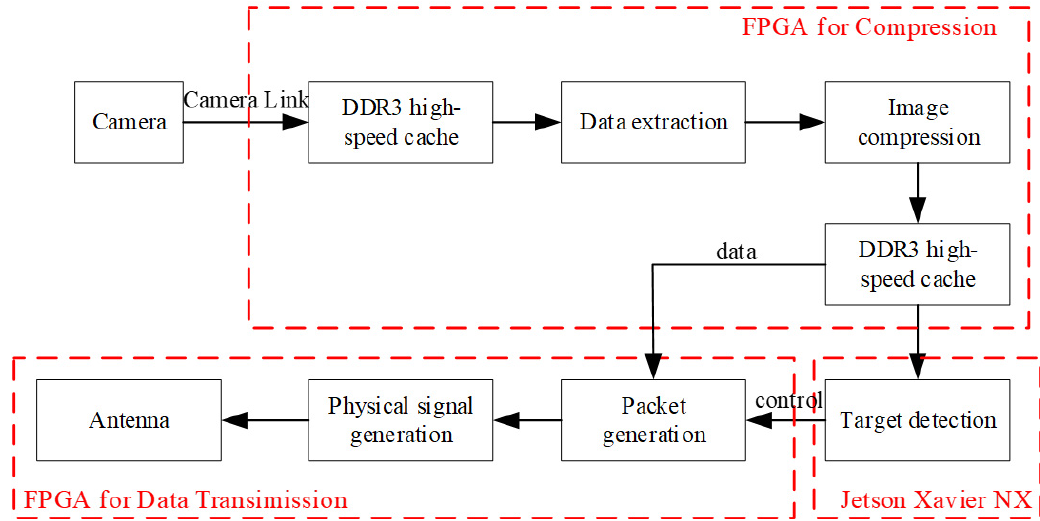
Figure 1. The procedure of an image compression and target detection system on a